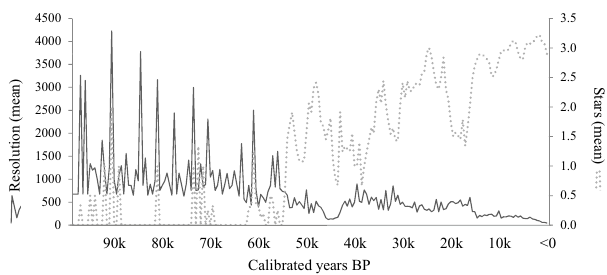
Figure 5. Changing mean sample resolution (left) and mean num- ber of stars (right) of the pollen database of northwest South Amer- ica during the period 100kcal to −